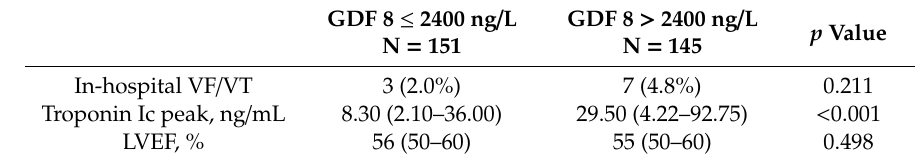
Table 3. Relevant outcomes according to high / low GDF8 levels (cuto ff on median GDF8 value).